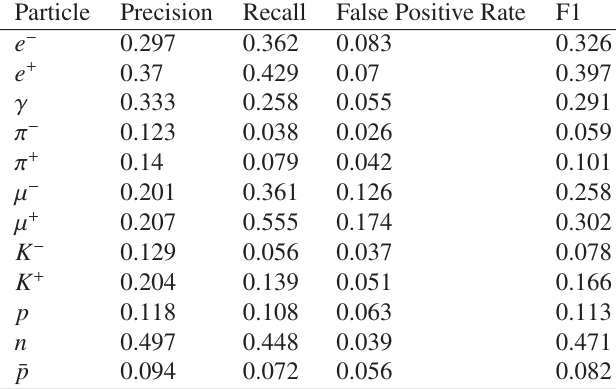
Table 5. Performance on particles